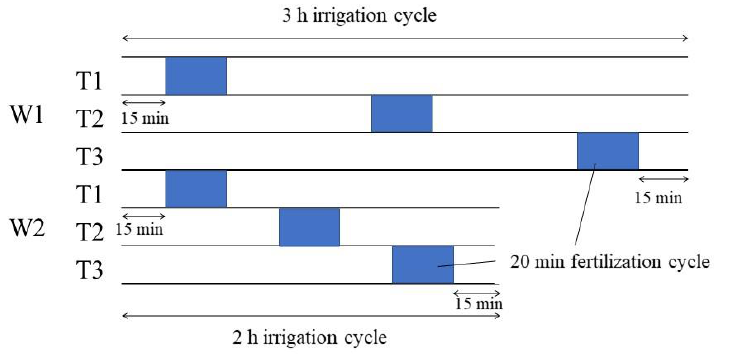
Figure 1. The specific scheduling of irrigation and fertilization at W1 and W2: W1 = irrigation rate of 30 mm; W2 = irrigation rate of 20 mm; T1 = fertilization time at the beginning of irrigation; T2 = fertilization time in the middle of irrigation; T3 = fertilization time at the end of irrigation. Table 1. Irrigation and fertilization scheduling during winter wheat season in